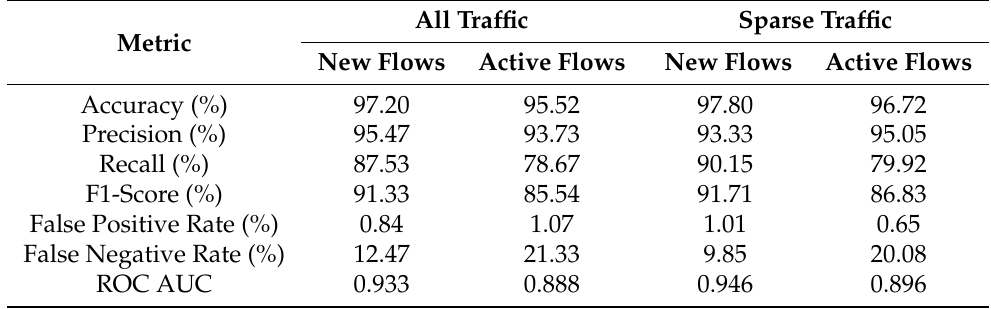
Table 4. PCA-SVM detection results for 10-s data slices with new and active flows as TCP flow values.